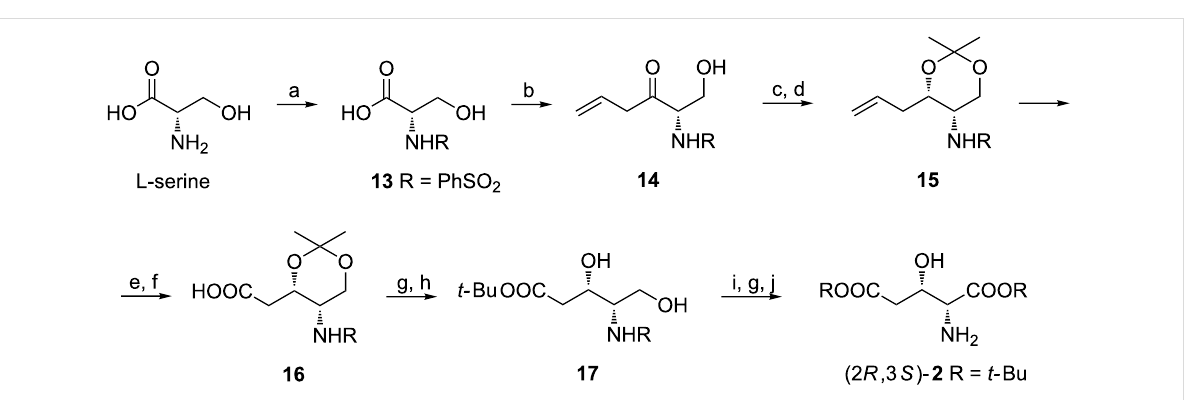
Scheme 4: Synthesis of di- tert -butyl ester of (2 R ,3 S )- 2 from L-serine. Reagents and conditions: a) PhSO 2 Cl, K 2 CO 3 , H 2 O; b) BuLi, THF; then H 2 C=CHCH 2 MgBr; c) L-selectride, THF; d) Me 2 C(OMe) 2 , PTSA, THF; e) O 3 , CH 2 Cl 2 , ether, then Ph 3 P; f) KMnO 4 , acetone, H 2 O; g) t -BuOH, N , N ′ - diisopropyl- O - tert -butylisourea, CH 2 Cl 2 ; h) MeOH, HCl (gas); i) O 2 , Pt, AcOEt, H 2 O; j) electrochemical